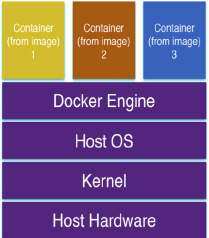
Figure 1. Docker will share the host OS kernel, but isolate di ff erent environments or ‘containers’ with respect to data, code, networking, etc.